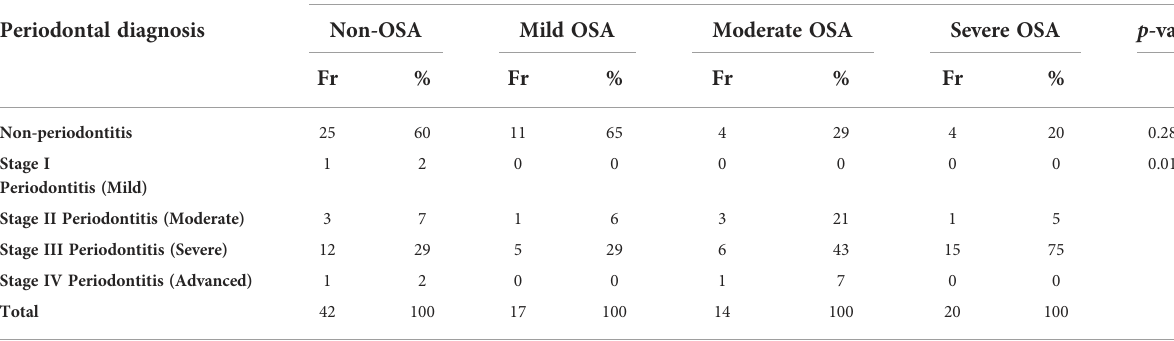
TABLE 3 Frequency and percentage of the periodontal condition according to apnea diagnosis.